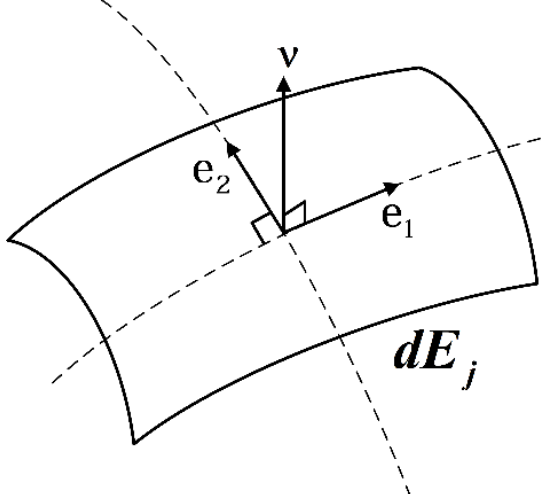
Figure 8. Vectors .